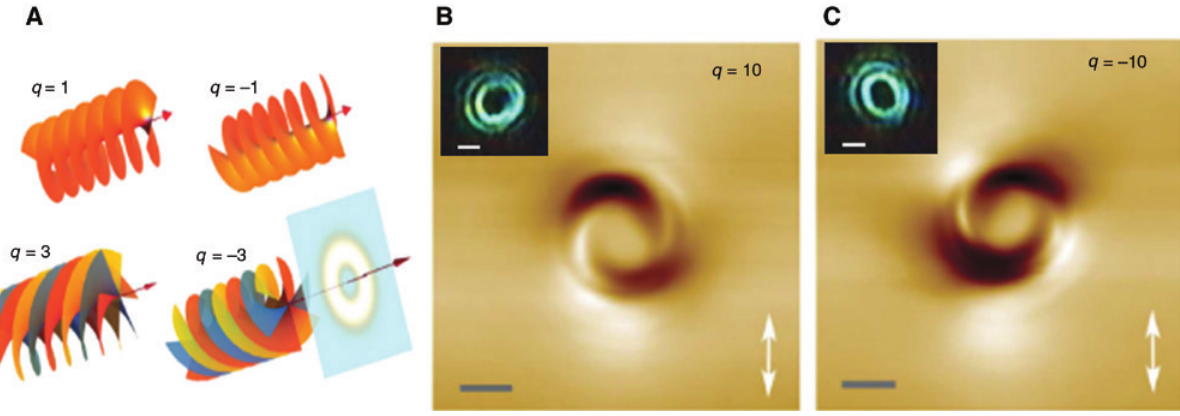
Figure 6: The spiral surface reliefs and the wavefront sensitivity. (A) Illustration of the helically shaped wavefronts (dependent on the vortex topological charge q ) and doughnut-shaped intensity profiles of optical vortex beams. (B) AFM images of the spiral surface reliefs generated by a focused, linearly polarized, q = 10 vortex beam (polarization direction indicated by white arrows). The inset shows the optical image of the irradiating light intensity pattern. (C) Same as in (B) for the spiral surface relief generated by a focused q = − 10 vortex beam. Scale bars: 1 μ m. Adapted with permission from Ref. [149], copyright 2012, Springer Nature.